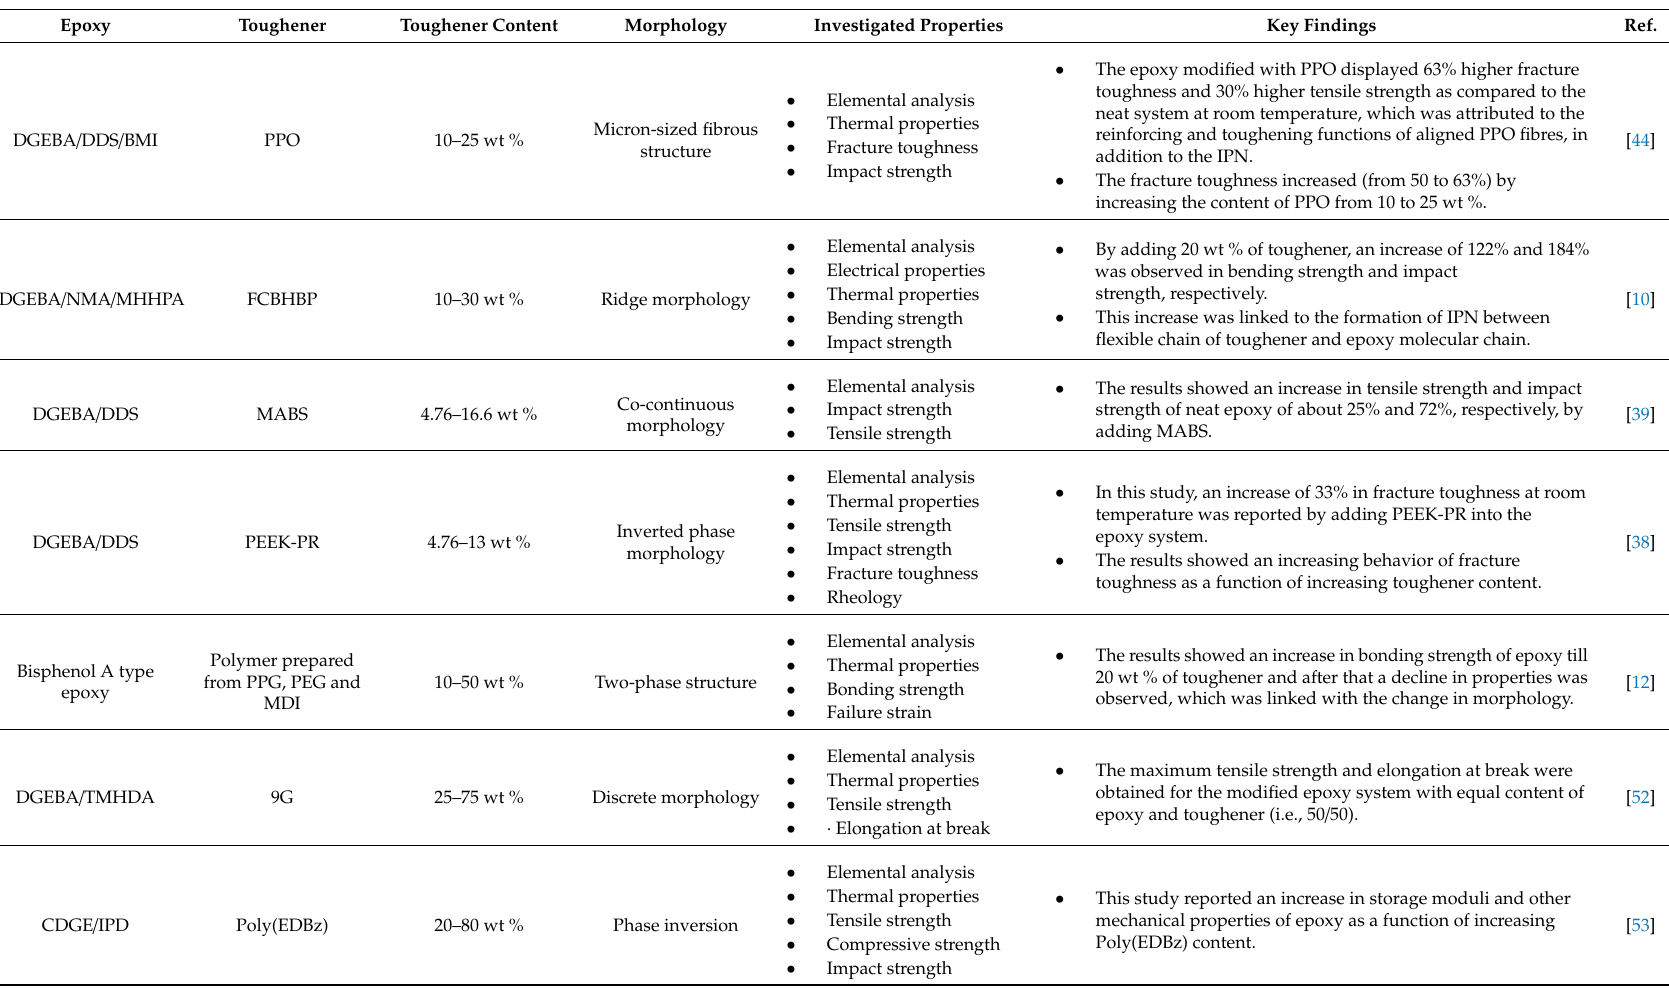
Table 1. Brief summary of di ff erent interpenetrating polymer network (IPN) based epoxy systems with thermoplastics